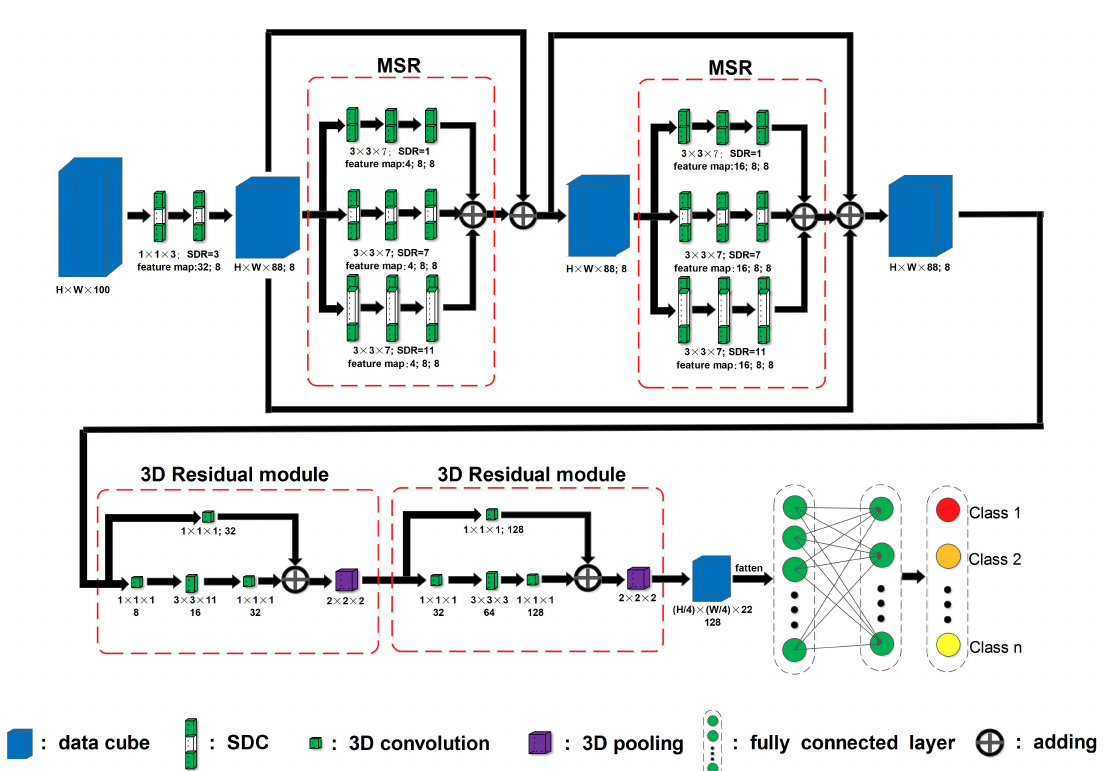
Figure 7. Schematic of Multiple Spectral Resolution 3D Convolutional Neural